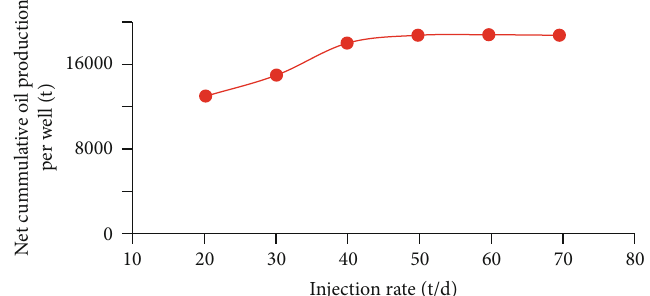
Figure 10: Relationship between net oil cumulative production and injection volume of viscosity reducer concentration for a single well.